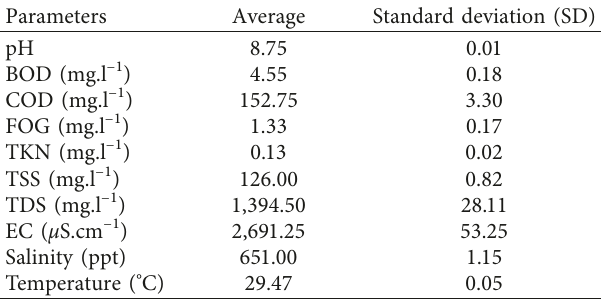
Table 3: Characterization of medical rubber glove factory primary- treated wastewater before incoming the HSFCWs